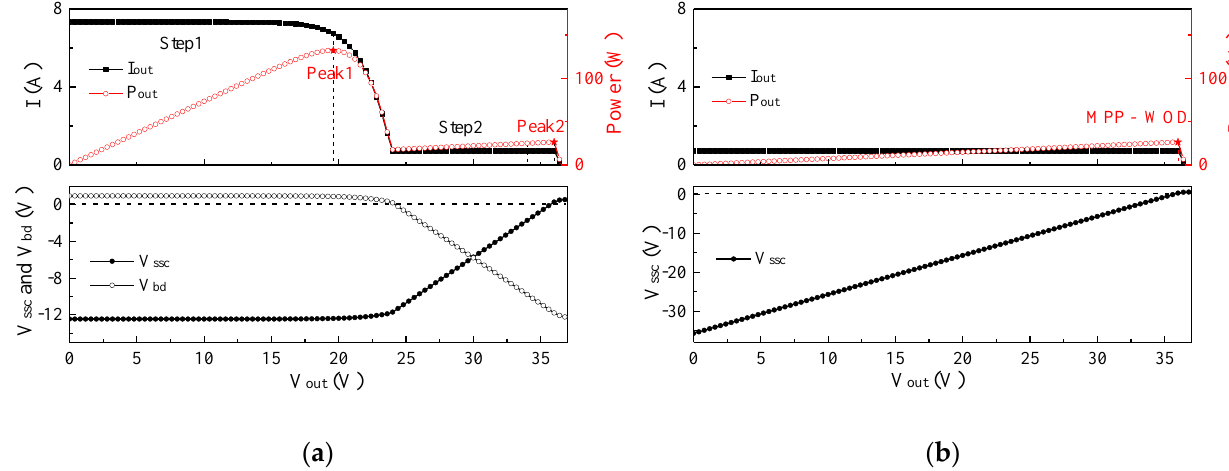
Figure 5. Output characteristics of the simulated PV module, and the terminal voltages of the shadowed solar cell and relevant bypass diode when a solar cell receives a shadow across 90% of its area: ( a ) module with bypass diode, ( b ) module without bypass diode.